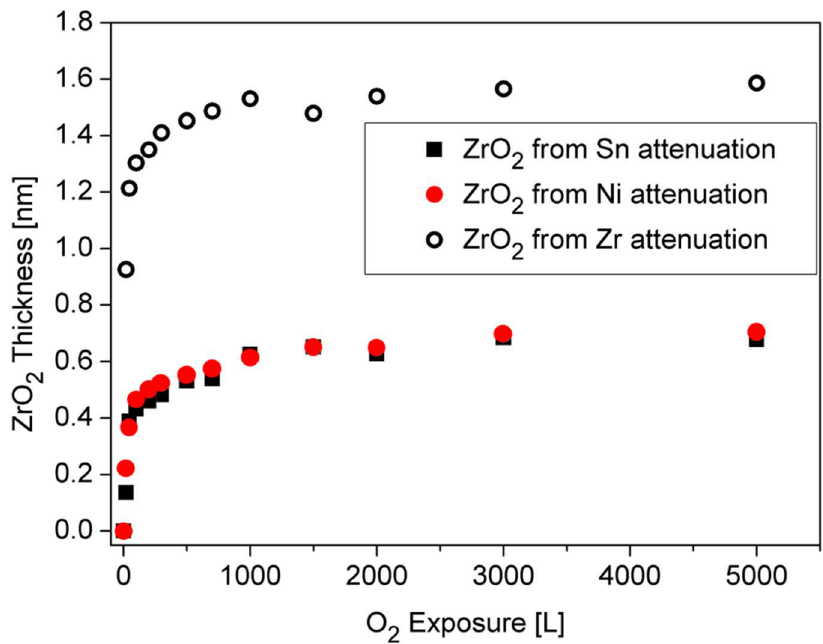
Figure 9. ZrO 2 thickness formed on the surface during oxygen exposure at RT, as calculated from the attenuation of the Sn, Ni and Zr signals.